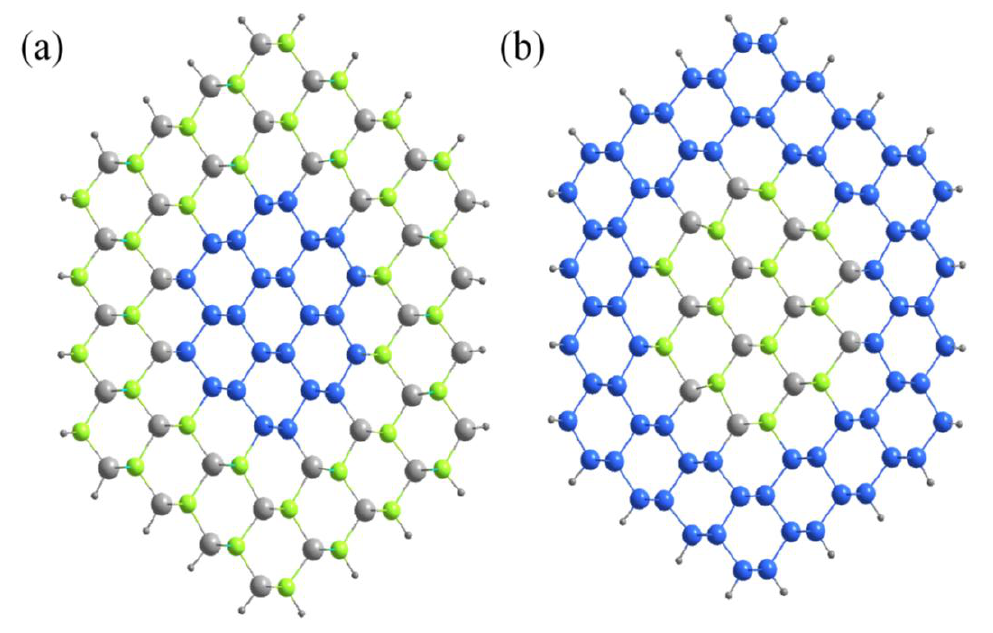
Figure 1. Top view of a typical ( a ) Si-core/ZnSe-shell and ( b ) ZnSe-core/Si-shell NWs along the [110] direction. The blue, grey and green spheres represent Si, Zn and Se atoms, respectively. The outer black spheres are pseudo hydrogen